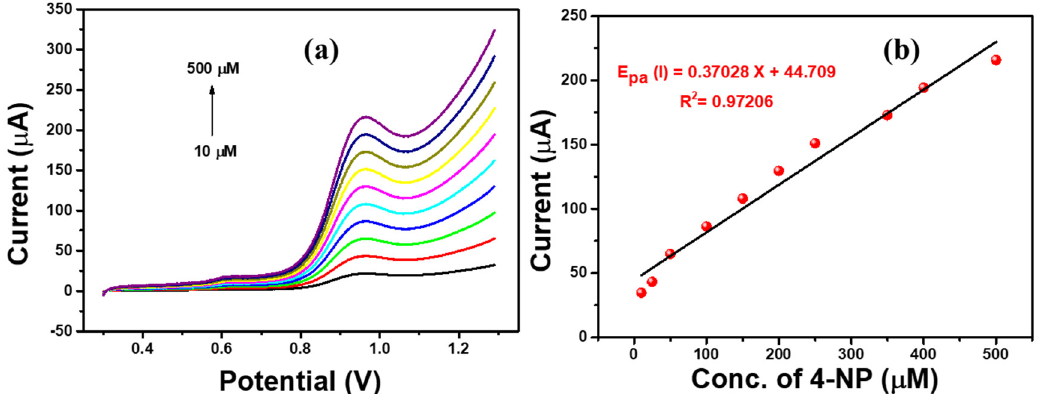
Figure 10. ( a ) LSV responses of Ag-ZnO/GCE at different 4-NP concentrations (10 µM to 500 µM) containing 0.1 M PBS (pH = 7) solution at a scan rate of 100 mV s − 1 . ( b ) Linear regression plot of current vs. 4-NP concentration. (Accumulation time: 2 min, catalyst loading volume: 10 µL).